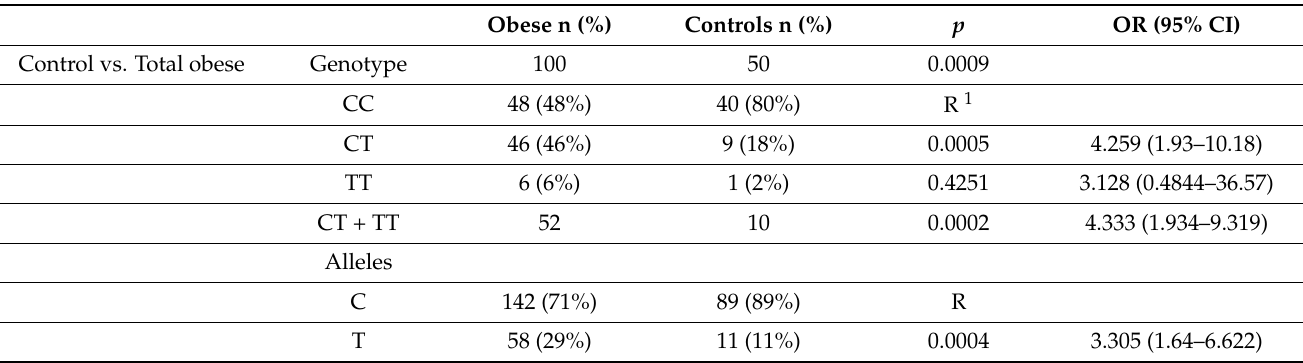
Table 2. Genotype distributions and allele frequencies of SNP rs3200401 in MALAT1 gene in con- trol vs. total obese group.